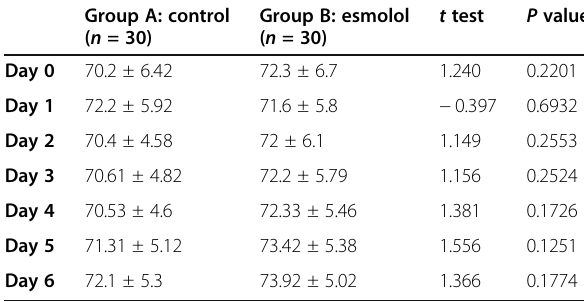
Table 3 Comparison between groups regarding